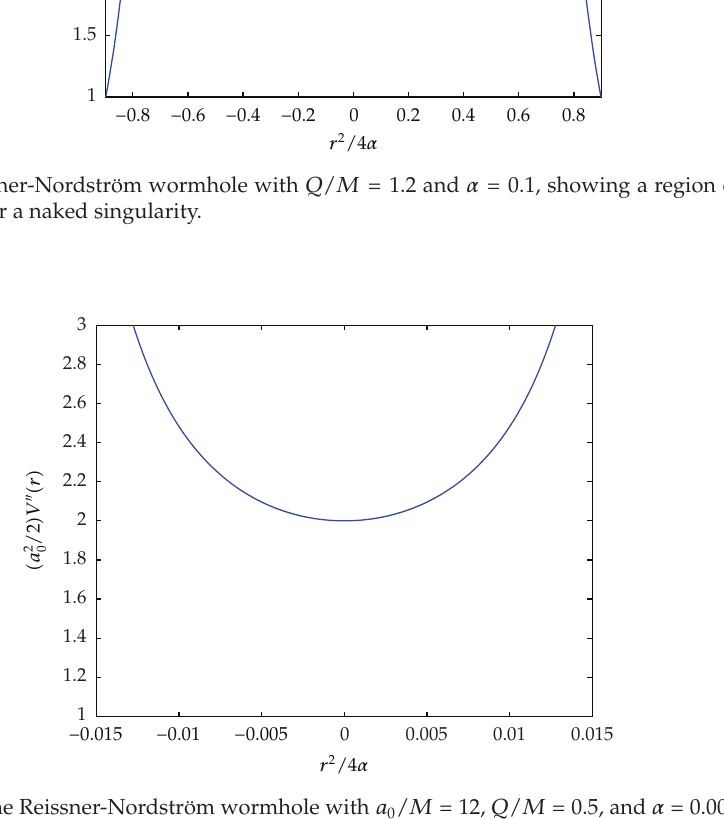
Figure 5: The Reissner-Nordstr¨om wormhole with a 0 /M (cid:5) 12, Q/M (cid:5) 0 . 5, and α (cid:5) 0 .